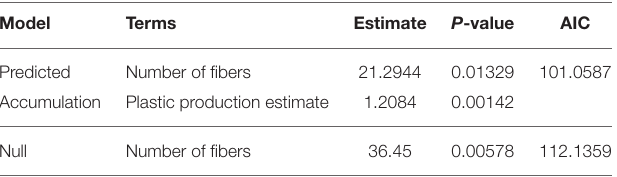
TABLE 2 | Results from the model of predicted accumulation of micro fibers in sediment through